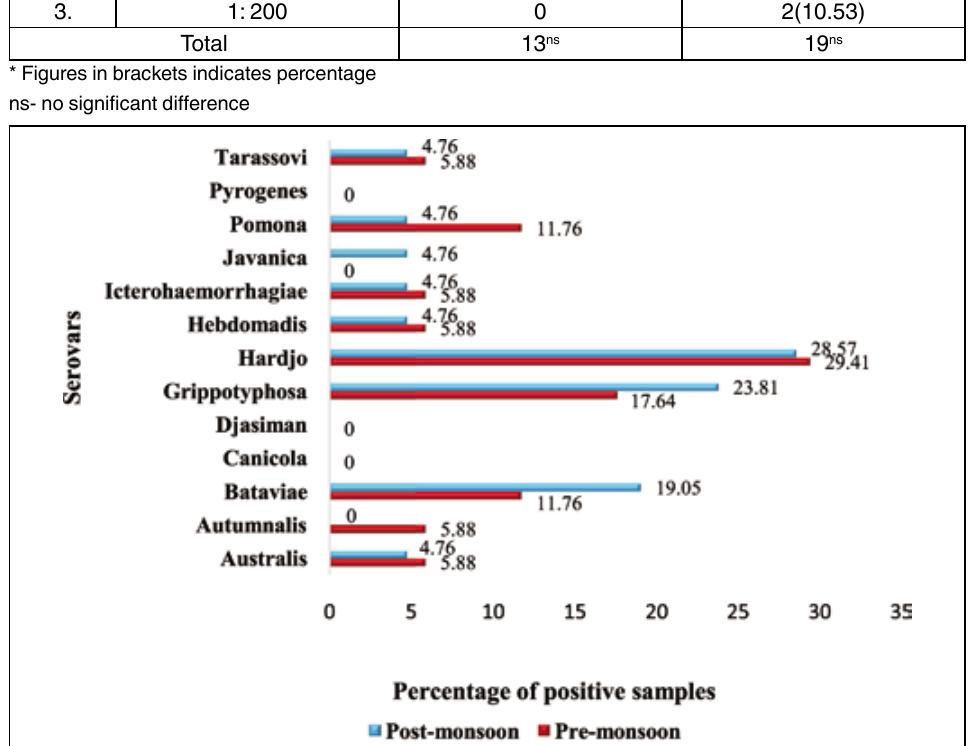
Fig. 2. Serovars in dairy cattle based on